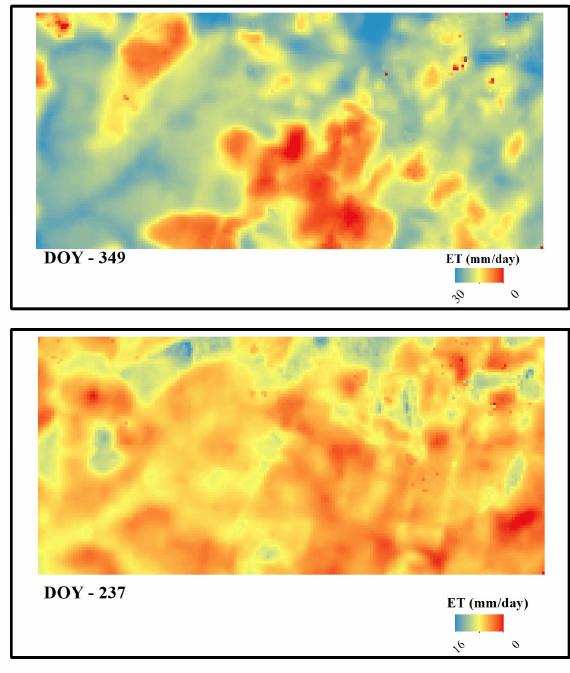
Figure 6. Daily evapotranspiration (mm/day) for Pampa Biome a) in summer (DOY 349) and b) in winter (DOY 237) During the winter the vary between maximum and minimum evapotranspiration is lower than during the summer, this result can be explained by the fact that during summer season the maximum and minimum LST variation is greater than during the winter.